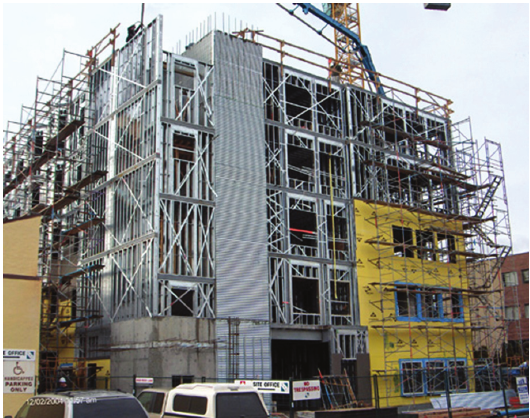
Figure 1. Building construction in Lightweight Steel Framing system 2